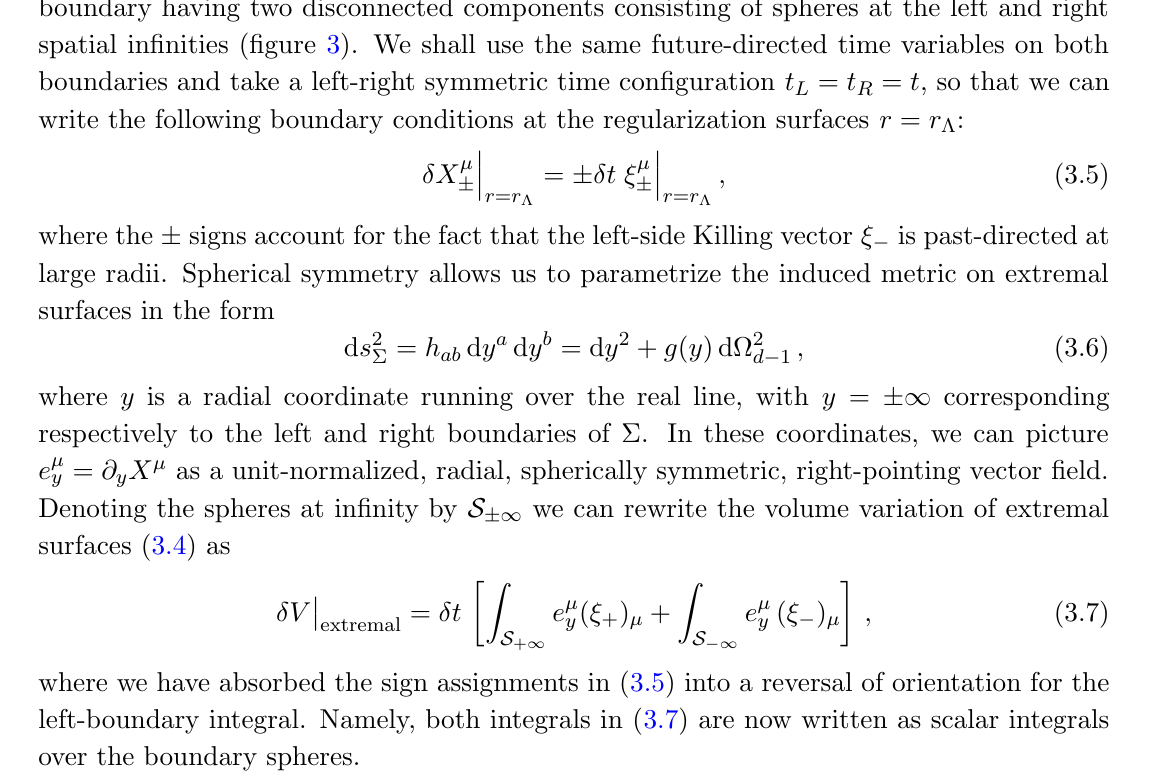
JHEP07(2020)169